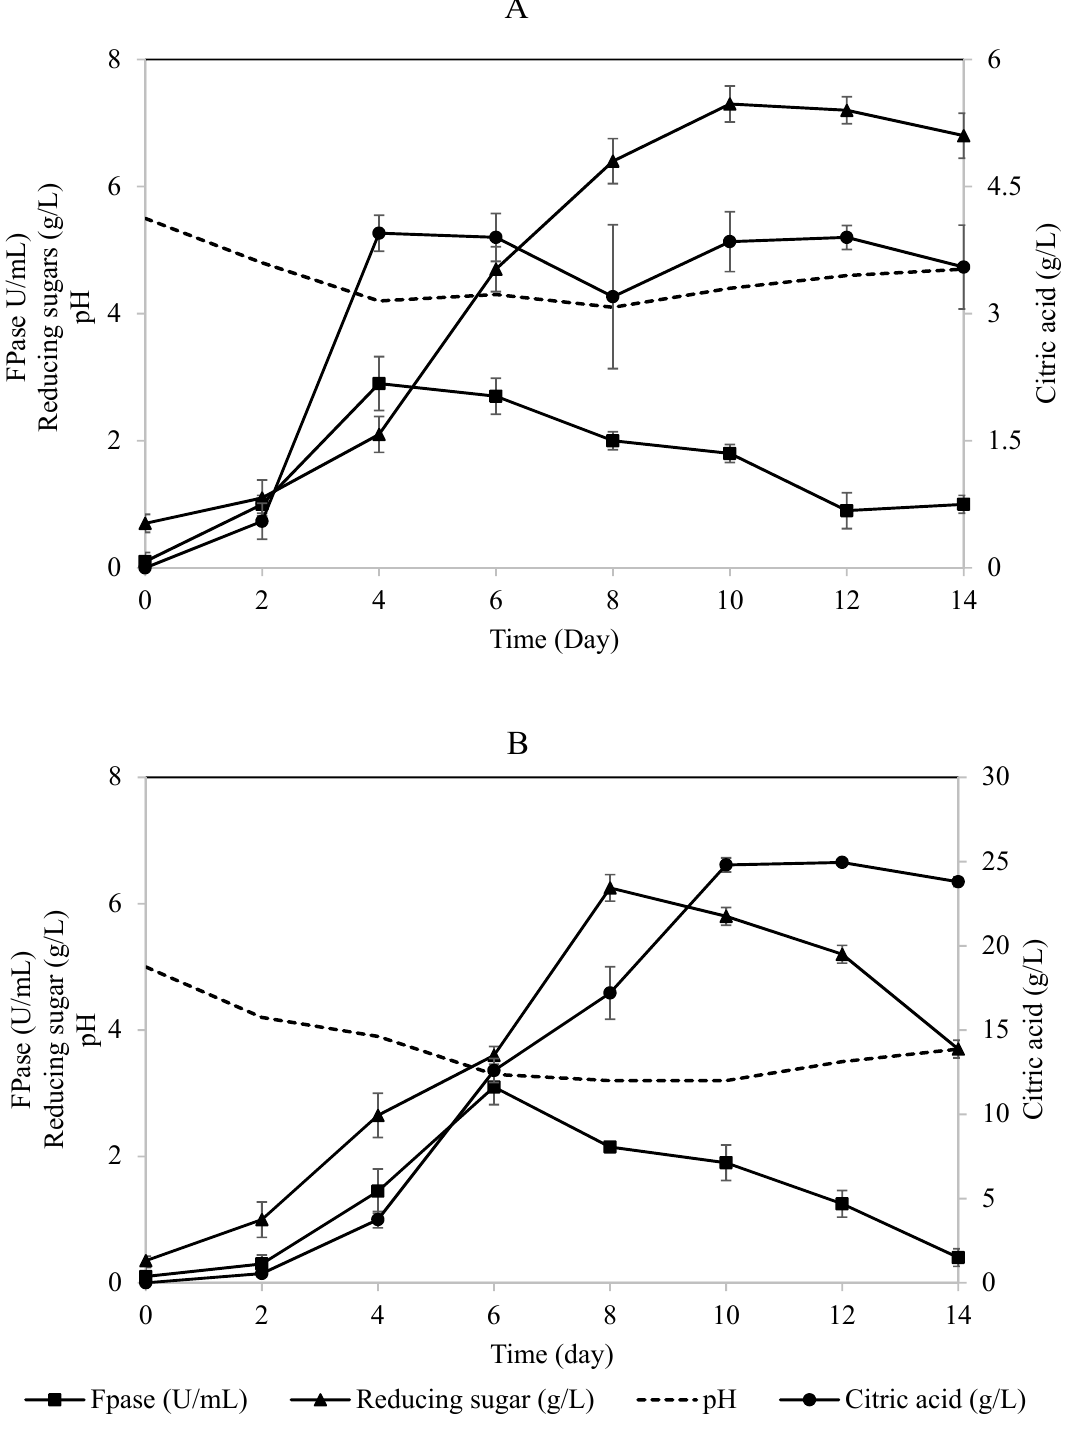
Figure 3. Time profile for the two-stage loofa sponge-packed column bioreactors for the simultaneous production of cellulase, citric acid, and reducing sugars by A. niger utilizing OMW supplied with 1% cellulose. ( A ) First-stage process; ( B ) second-stage process. Error bars represent the standard error of the mean values.